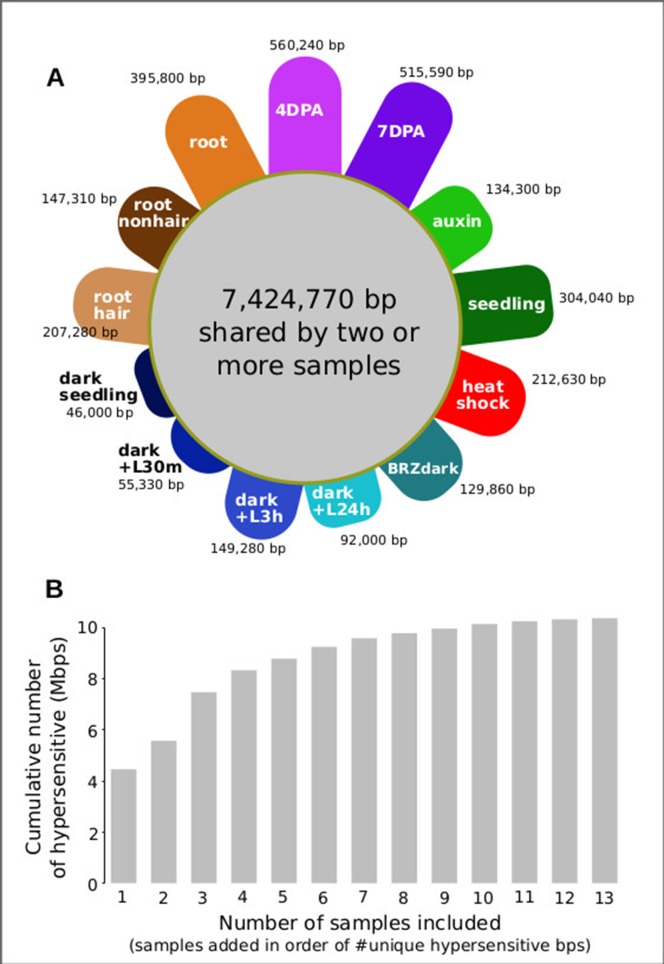
Seed coat-enriched samples contribute the largest number of novel hypersensitive bases in a diverse set of samples. (A) Colored petals denote number of unique hypersensitive base pairs in each sample, gray circle denoted hypersensitive base pairs shared by two or more samples. Sample labels as in
Figure 5
; samples are grouped by seed coat-enriched samples, light-grown seedlings, dark-grown seedlings, and root samples. (B) Cumulative number of hypersensitive sites plateaus. Graph was generated by adding samples based on their number of unique hypersensitive base pairs, starting with the largest (4 DPA) and ending with the smallest (dark seedling).